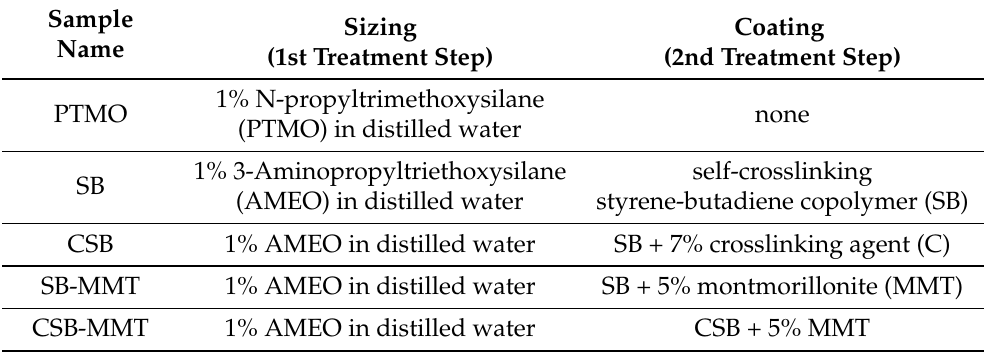
Table 1. Surface modification of ARG